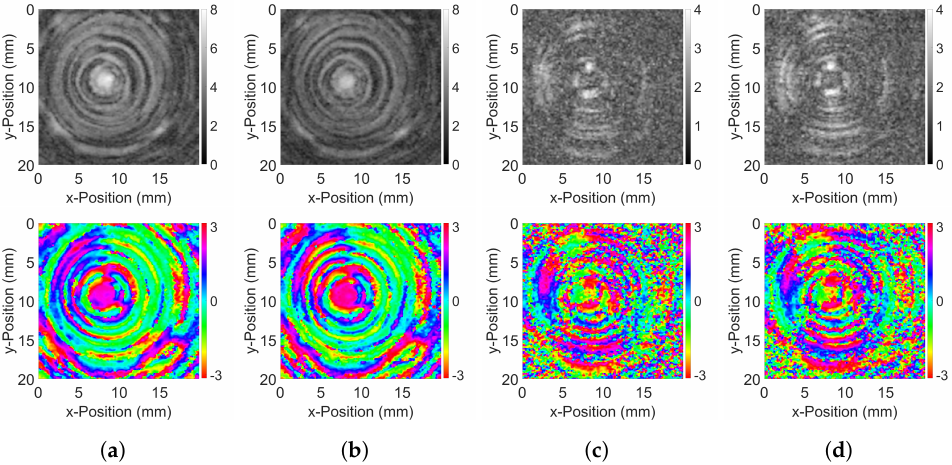
Figure 9. Intensity (top row) and phase images (bottom row) at 0.5 THz for wood sample #2 for measurements at different polarizer orientations [ P 1 , P 2 ]: a ) [45 ◦ , 45 ◦ ]; ( b ) [135 ◦ , 135 ◦ ]; ( c ) [135 ◦ , 45 ◦ ]; ( d ) [45 ◦ , 135 ◦ ].